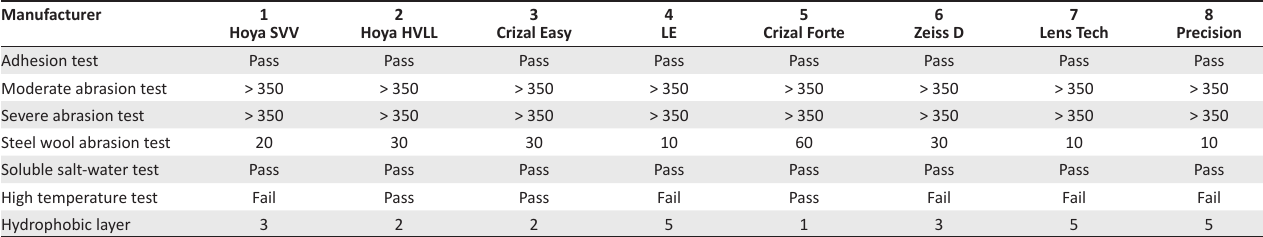
TABLE 2: A comparison of all tests performed on the antireflection coatings.